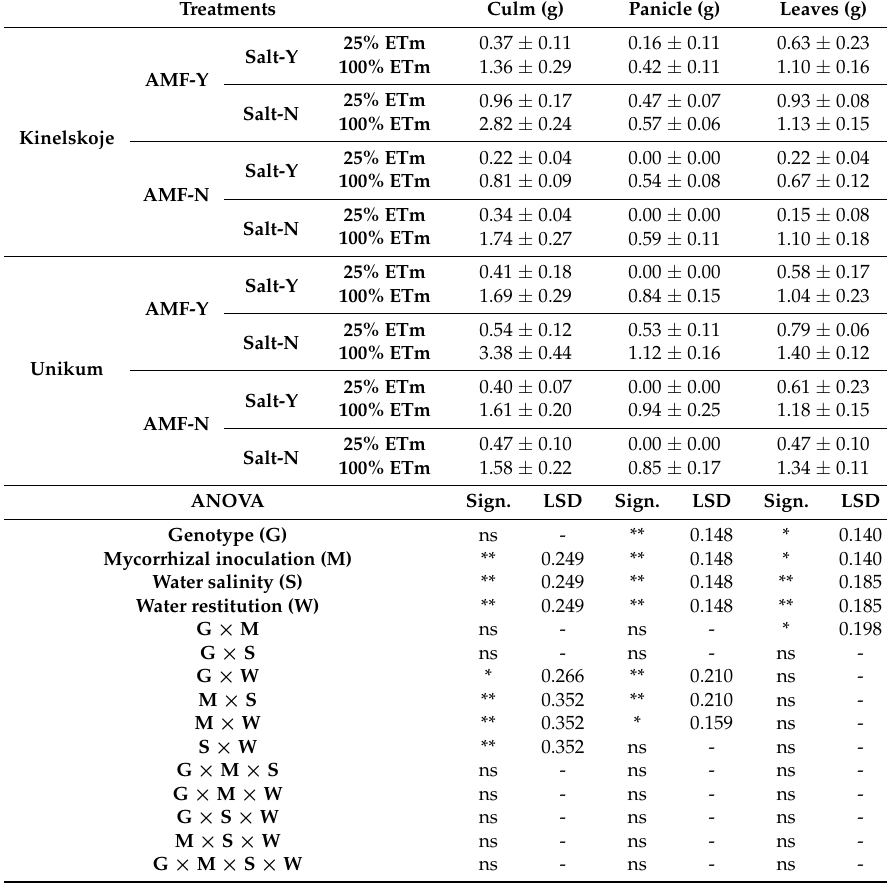
Table 4. Proso millet fresh weight yield